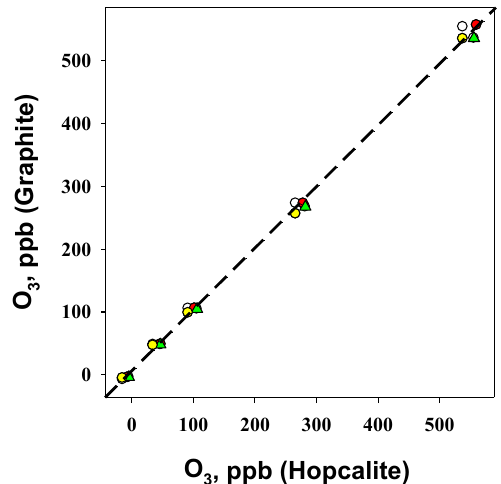
Figure 2. Plot of ozone measured with the graphite scrubber (at 100 ◦ C) vs. that measured with the conventional Hopcalite scrub- ber. The different symbols/colors represent different sets of graphite tubes used within the heater during our reproducibility testing. Re- sults were obtained using a 2B Technologies Model 202 single- beam ozone analyzer. The dashed line drawn is the 1:1